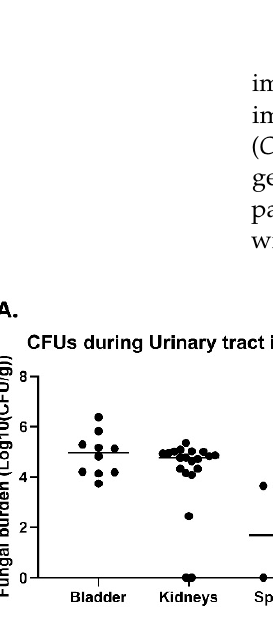
Figure 1. C. glabrata colonization of tissues in the UTI model and subsequent immune response. ( A ) Ten mice were challenged with 2.5 × 10 8 C. glabrata cells directly into an emptied bladder. Three days post infection, mice were euthanized, and colony forming units (CFUs) were determined in the bladder, the kidneys, and the spleen. ( B ) Production of GM-CSF; ELISA was carried out for supernatant of homogenized, infected bladders, kidneys, and spleens and their non-infected counter parts. Colonization of the kidneys causes significantly increased production of the macrophage attraction factor GM-CSF (unpaired t -test, p = 0.000635). ( C ) Colonization of the spleen causes increased production of IL-1beta (unpaired t -test, p = 0.007897). Error bars show standard deviations. Significance: **** p < 0.0001.